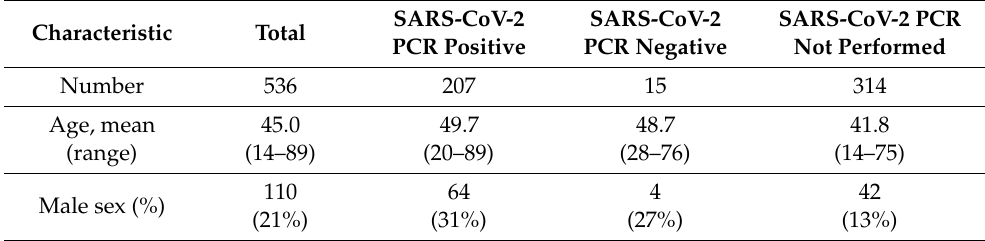
Table 2. Characteristics of the study